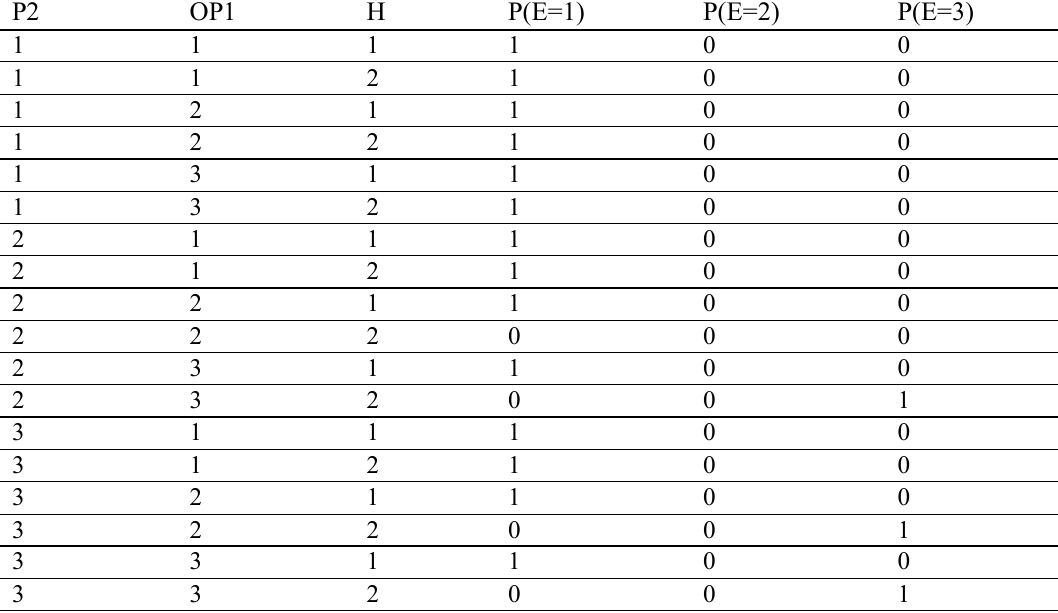
Table 12. States related to node E